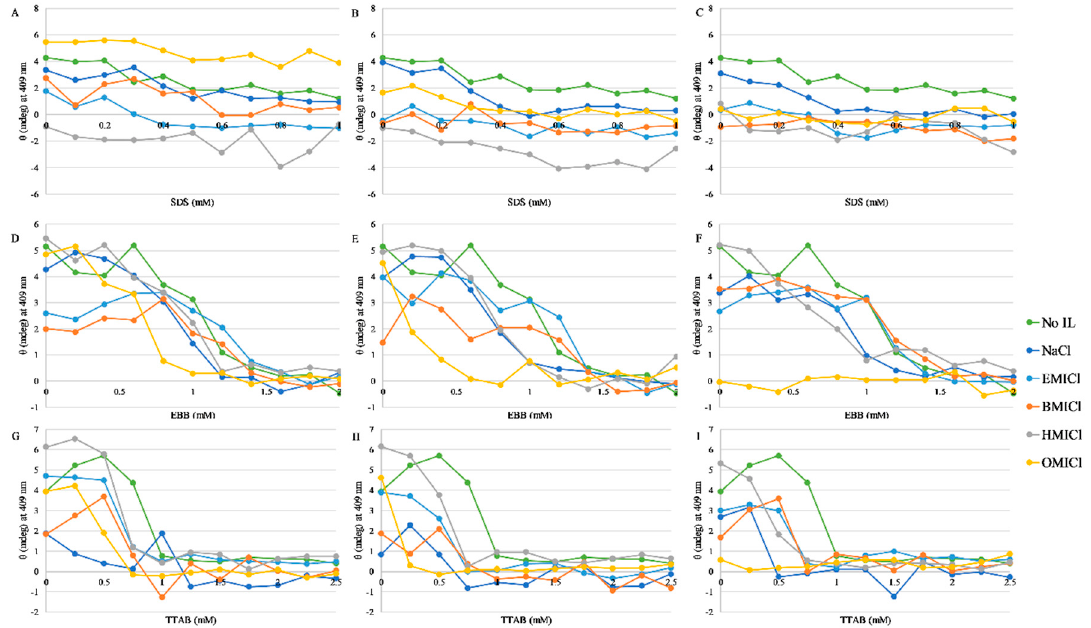
Figure 5. Dissociation of heme from myoglobin by circular dichroism spectroscopy. Data were collected at 409 nm. Color coding for each IL or control is indicated in the figure. Panels ( A–C ) are with SDS, ( D – F ) are with EBB, and ( G–I ) are with TTAB. Panels ( A ), ( D ), and ( G ) (left column) are supplemented with 50 mM of RTIL; panels ( B ), ( E ), and ( H ) are supplemented with 150 mM RTIL; panels ( C ), ( F ), and ( I ) are supplemented with 300 mM RTIL. Data represent the average of 16 replicate scans of a single representative sample and lines are not fits but are only to guide the eye.